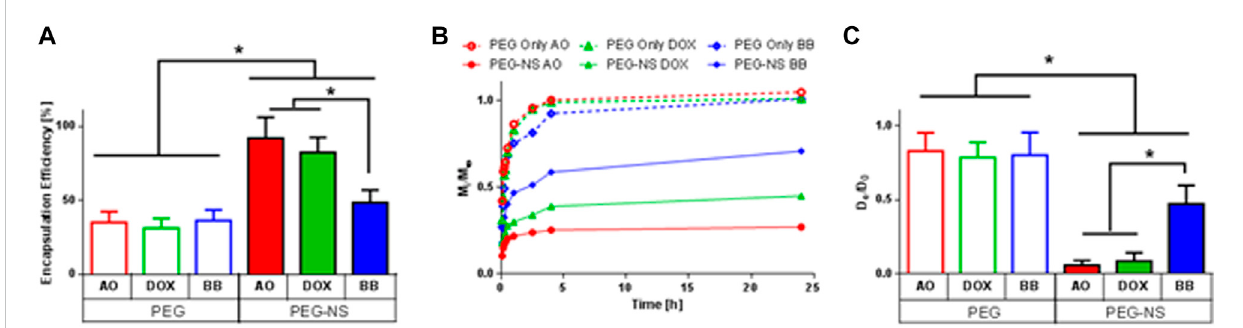
FIGURE 7 EffectofSmallMoleculeChargeonEncapsulationEf fi ciencyandReleaseKinetics. (A) Encapsulationef fi ciencyofAO,DOX,orBBfollowinghydrogel microsphere fabrication. * indicates statistically signi fi cant difference between groups ( n = 4, p < 0.05). (B) Fractional release pro fi les of AO, DOX or BB from microspheres containing 0 μ g/mL NS (PEG) or 100 μ g/mL NS (PEG-NS) over short release times. Error bars are omitted here to improve clarity of graph ( n = 4). (C) Calculated diffusivities based on Eq. 4 and data from (B) * indicates statistically signi fi cant difference between groups ( n = 4, p <